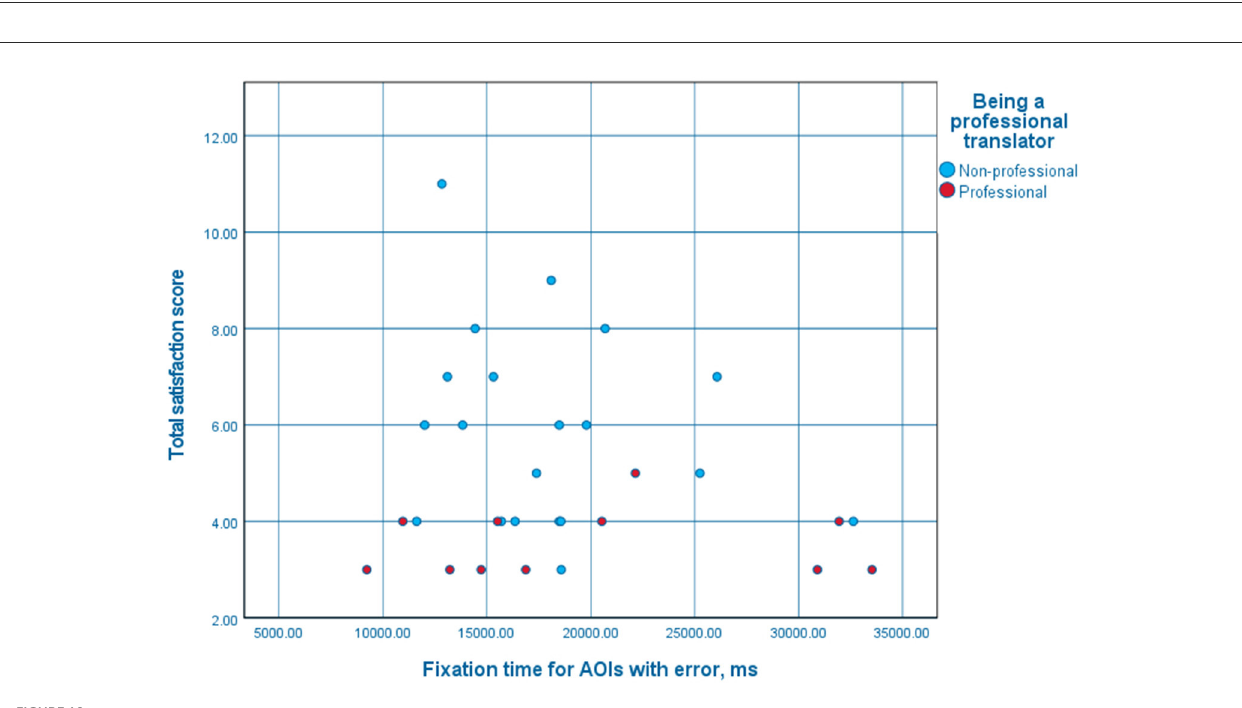
FIGURE10 A scatter plot of fixation times for AOIs with errors and total satisfaction